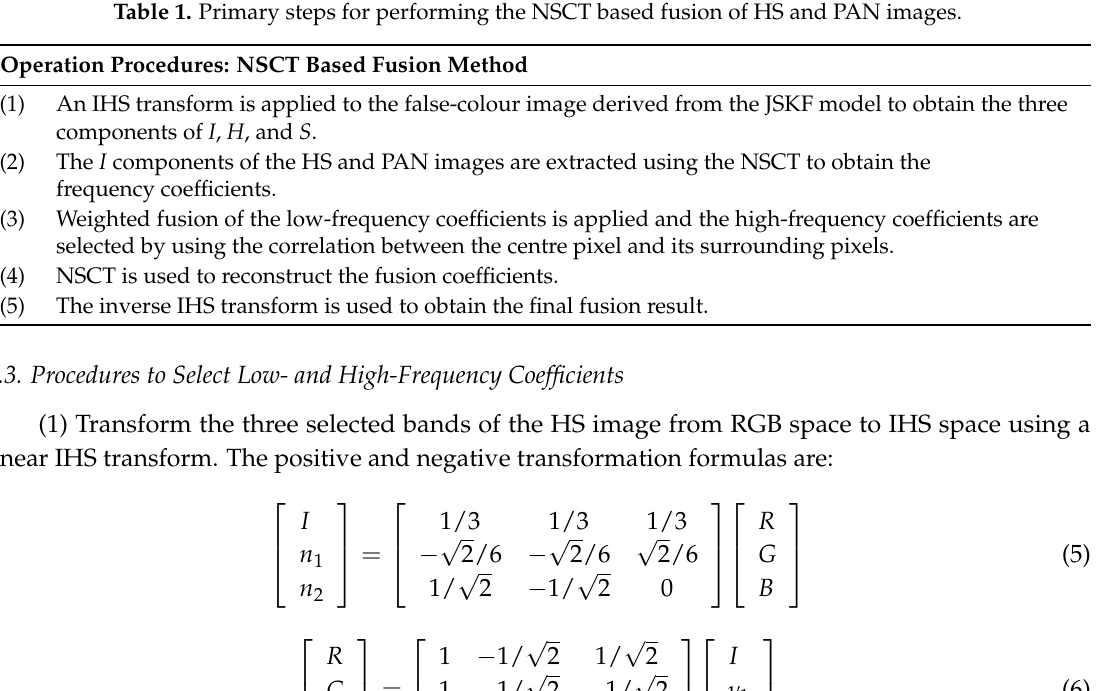
Table 1. Primary steps for performing the NSCT based fusion of HS and PAN